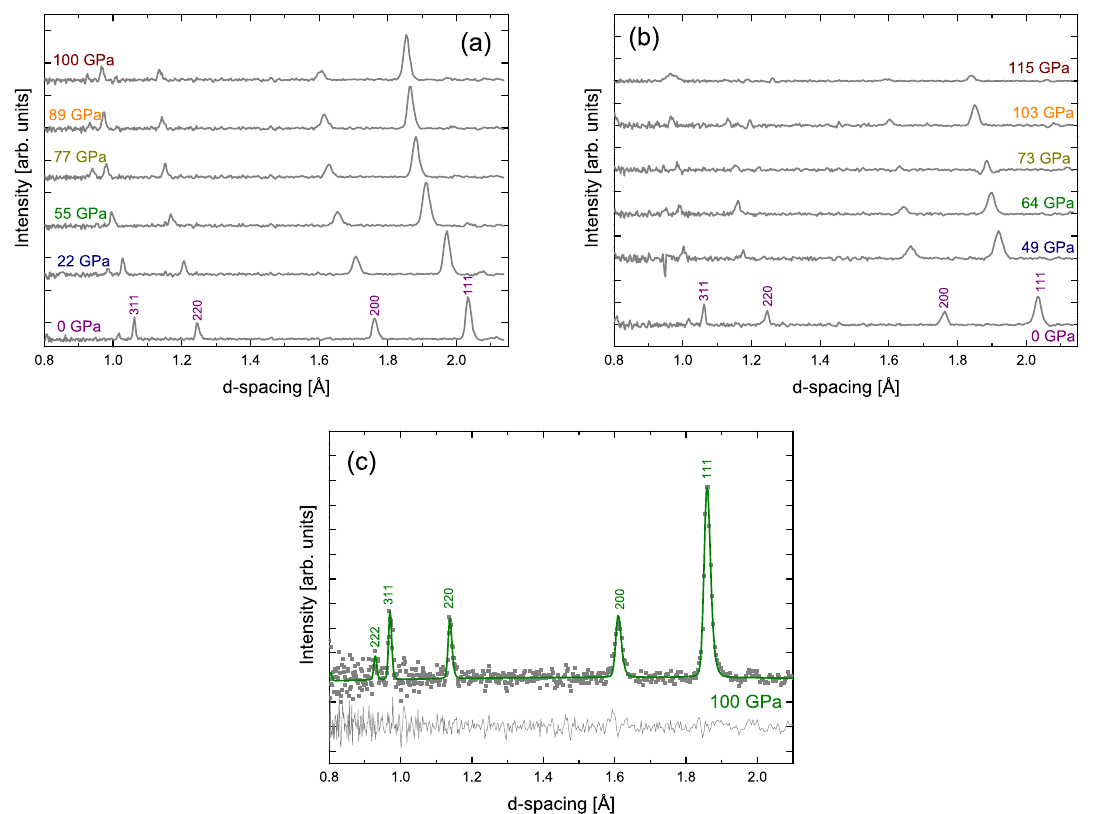
Figure 3. High pressure neutron diffraction of nickel. Neutron diffraction data obtained from Ni in a cell with ( a ) 800 µm culets and ( b ) 600 µm culets. ( c ) Quantitative Rietveld refinement performed on Ni measured at 100 GPa in the 800 µm culet cell after full background correction. The data set is presented by the measured data (grey), the calculated data (colored) and the difference function beneath. In all plots, Ni is additionally indexed as per Ni’s cubic unit cell, Fm 3 m